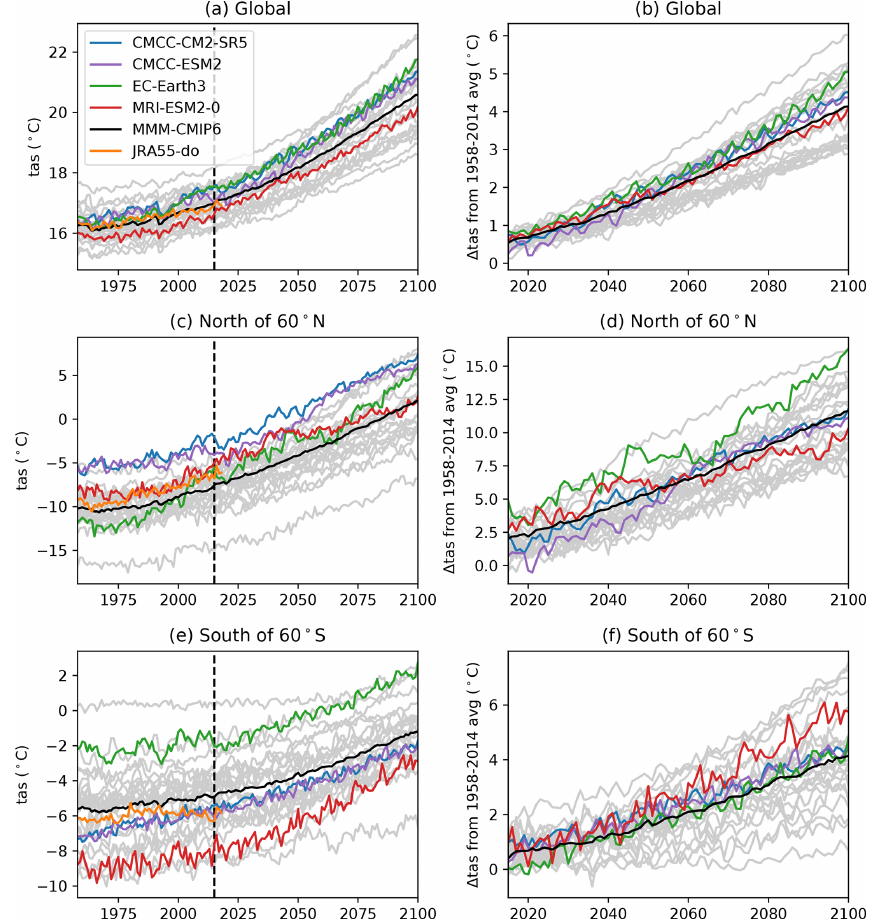
Figure 3. Comparisons of historical and projected global and polar warming simulated by 26 CMIP6 models over the historical period (1958– 2014) and the projection period under the SSP5-8.5 scenario (2015–2100). Time series of annual mean surface air temperature averaged over the ocean grid cells of (a) the globe, (c) the Northern Hemisphere north of 60 ◦ N, and (e) the Southern Hemisphere south of 60 ◦ S. Projected changes in annual mean surface air temperature averaged over the ocean grid cells of (b) the globe, (d) the Northern Hemisphere north of 60 ◦ N, and (f) the Southern Hemisphere south of 60 ◦ S, relative to their averages during 1958–2014. Blue, purple, green, and red denote 4 of the 26 models that provide the atmospheric output at the temporal resolutions needed for the projection experiments of IAMIP2. Grey denotes the remaining 22 models. Black denotes the multi-model mean of the 26 models. Orange denotes the JRA55-do dataset used for the atmospheric forcing for the historical experiment of